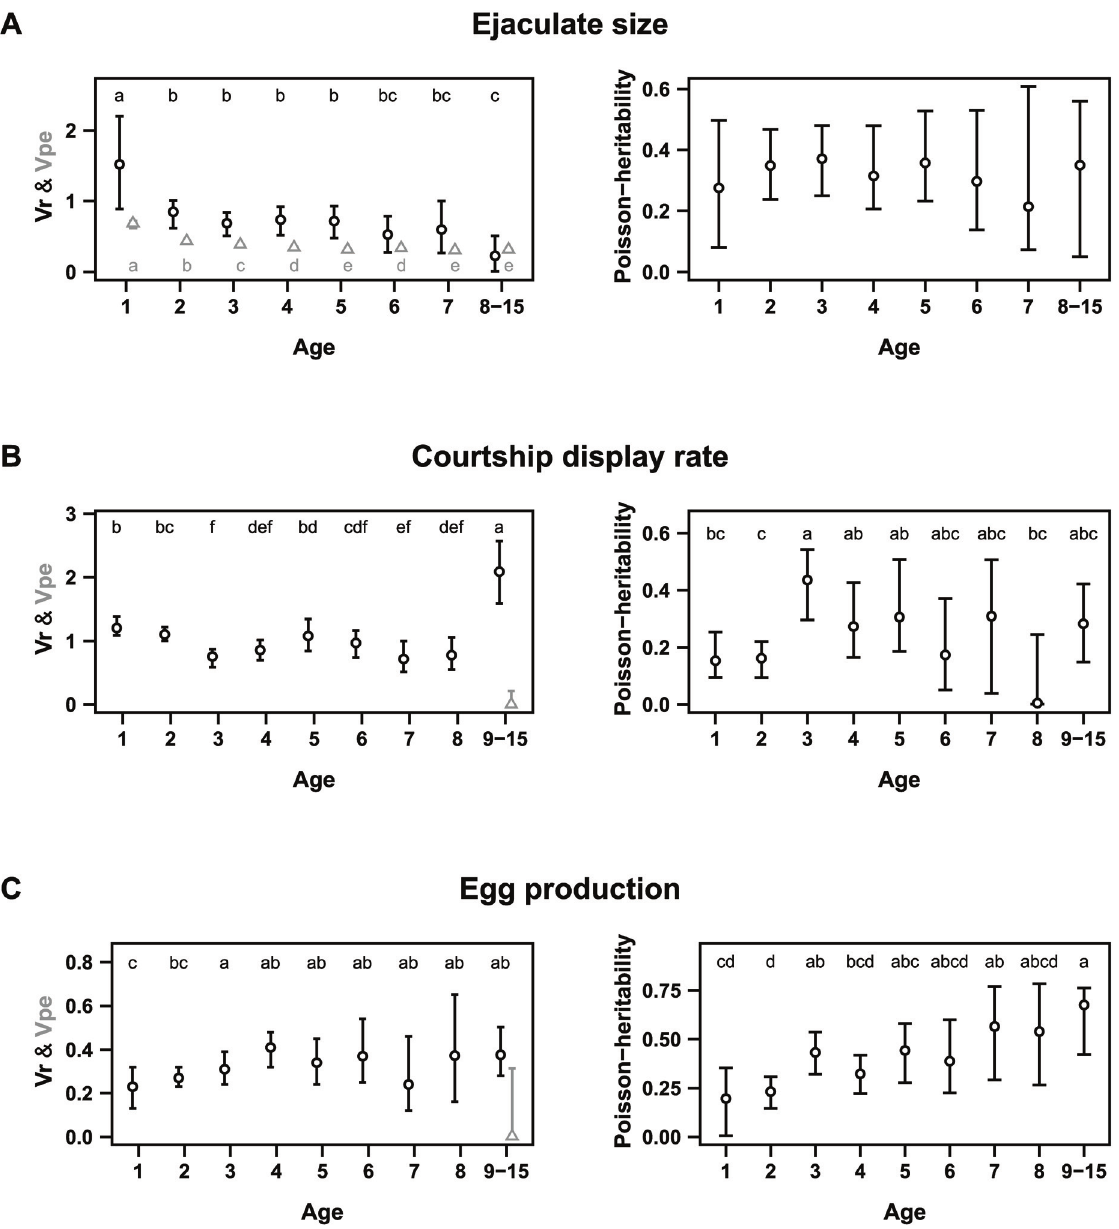
Fig 3. Variation of non-genetic variance components across ages. Vr (residual variances), Vpe (permanent environment variance) and Poisson- heritability are provided for (A) ejaculate size, (B) courtship display rate and (C) egg production. In the left column, Vr are presented with black circles and Vpe with grey triangles. The letters represent significant differences between posterior estimates (see S2 Text for post-test details). Models were run using MCMCglmm package